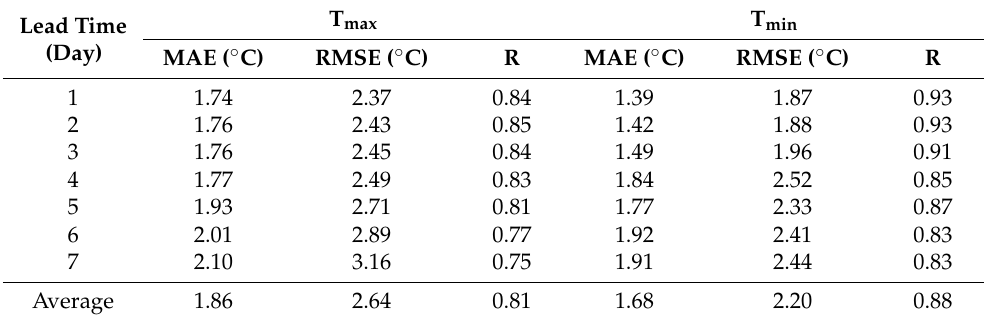
Table 2. The T max and T min forecasts statistical index.